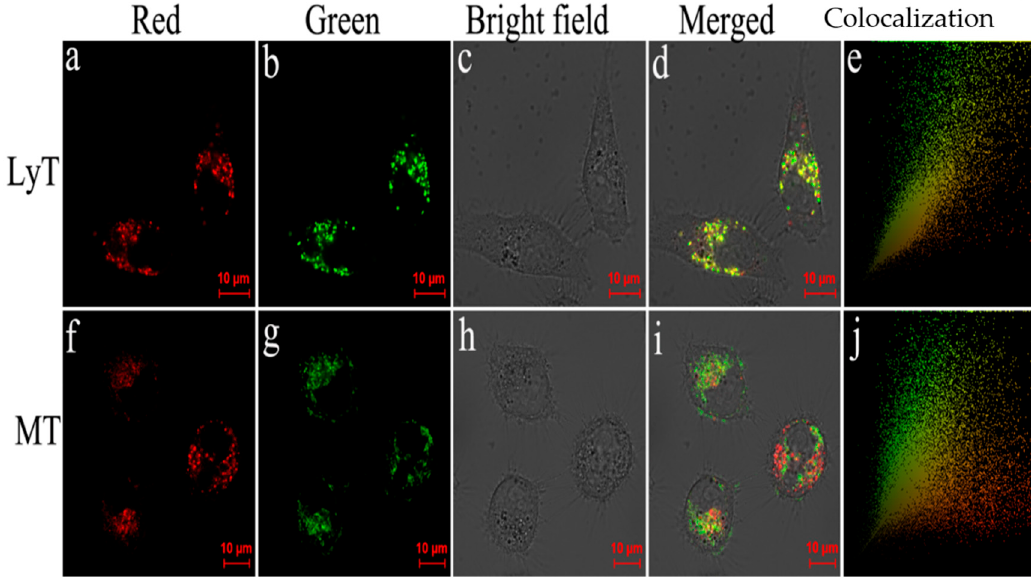
Figure 6. Colocalization experiments of BPO-DNSP with LyT ( a – e ) and MT ( f – j ) in HeLa cells. ( a ) and ( f ) fluorescence image of BPO-DNSP (10 μ M) on red channel ( λ em = 620–720 nm) with excitation at 560 nm; fluorescence image of 1 μ M LyT ( b ) and MT ( g ) on green channel ( λ em = 510–600 nm) with excitation at 488 nm; ( c ) and ( h ) image from bright field; ( d ) and ( i ) merged image of red, green, and bright field channels, colocalization of BPO-DNSP with ( e ) lysosome tracking (LyT) ( j ) and mitochondrial targeting (MT).